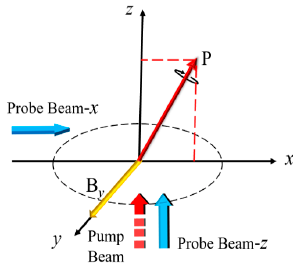
Figure 1. When the magnetic field is input along the y axis, the spin polarization of the atoms deviates from the pumping z axis and stabilizes at the angle between the z axis and the x axis; the x and z axis probe light undergoing an oscillation and decay process under the action of the pumping light modulation probes the x and z axis polarization responses, respectively.